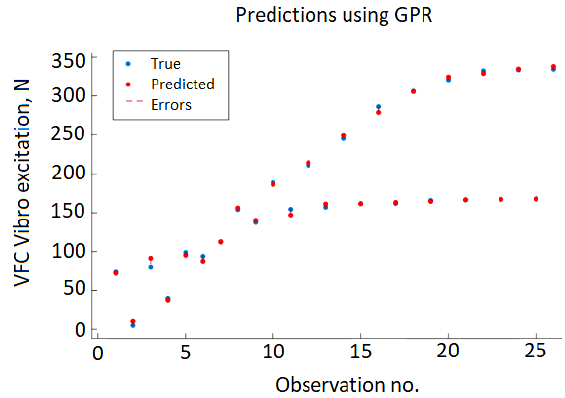
Figure 9. Testing data results of the GPR model.